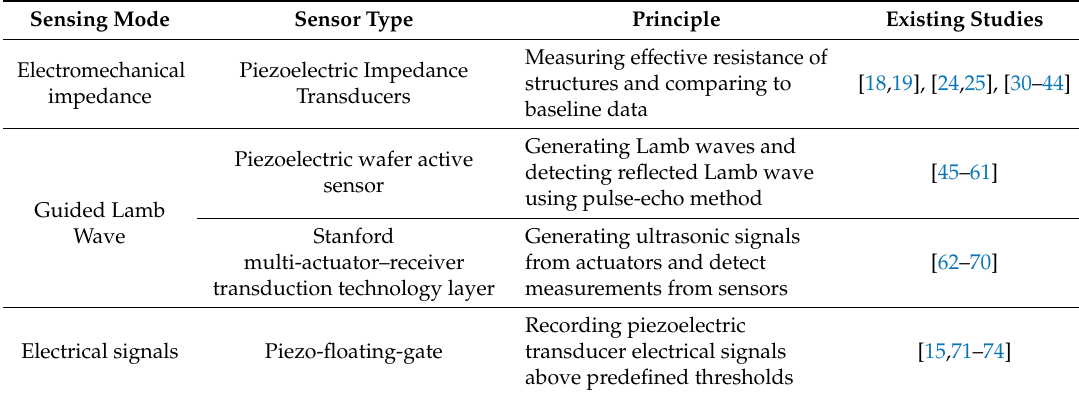
Table 1. An overview of studies focused on using the piezoelectric sensing techniques in